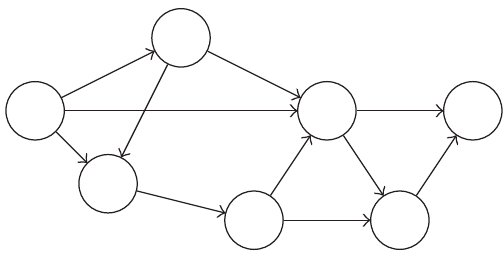
Figure 3: A simple dataflow program as a graph.